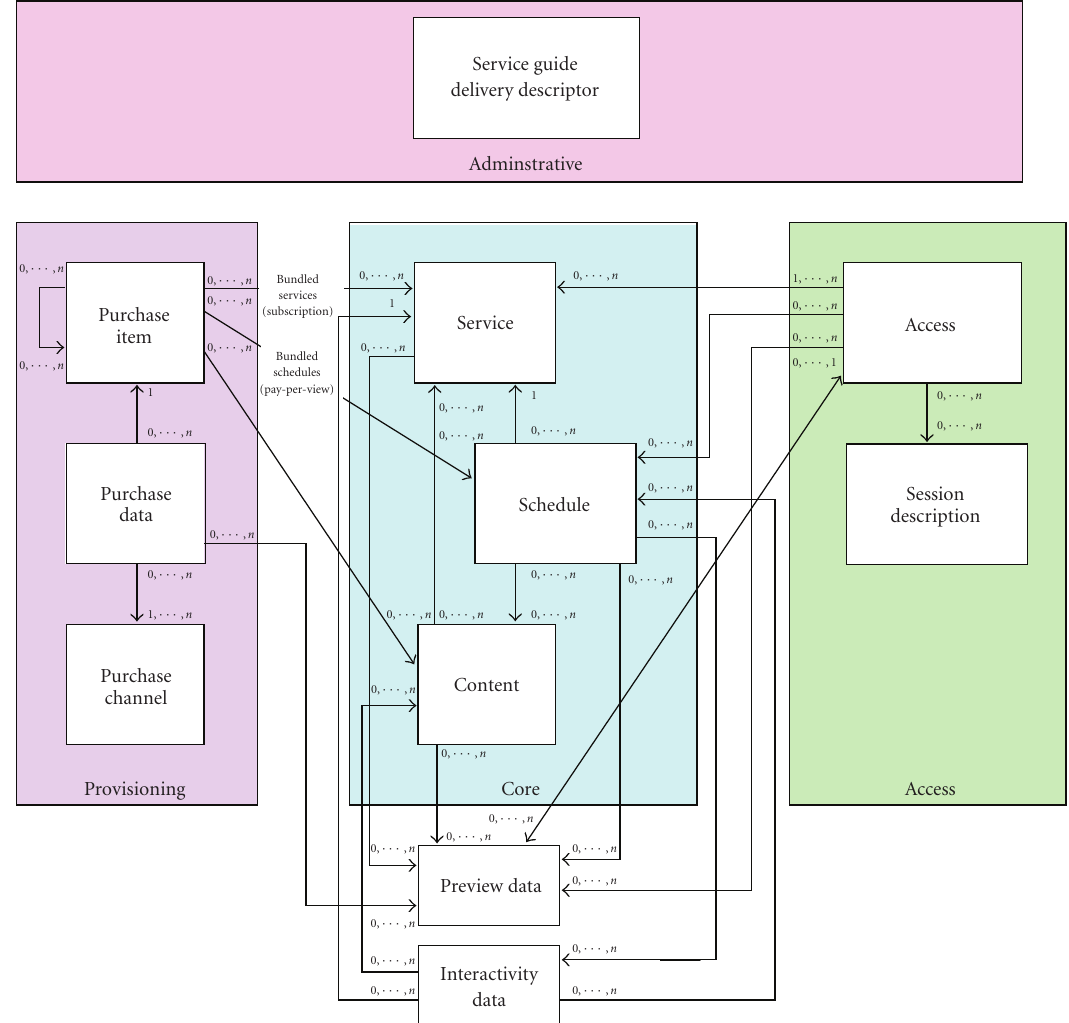
Figure 13: Logical structure of OMA BCAST service guide.